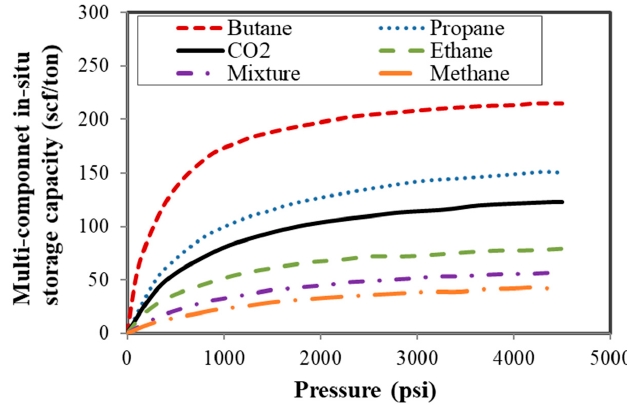
Figure 7. Isothermal adsorption of different components from Ambrose et al. Reprint with permission [53]; 2011; Society of Petroleum Engineers.